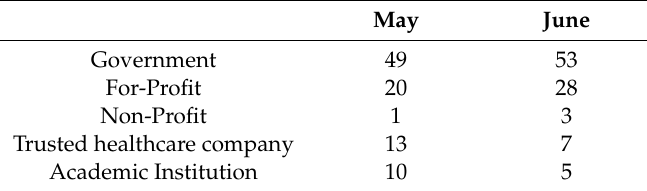
Table 1. Origin of COVID Apps in May and June 1